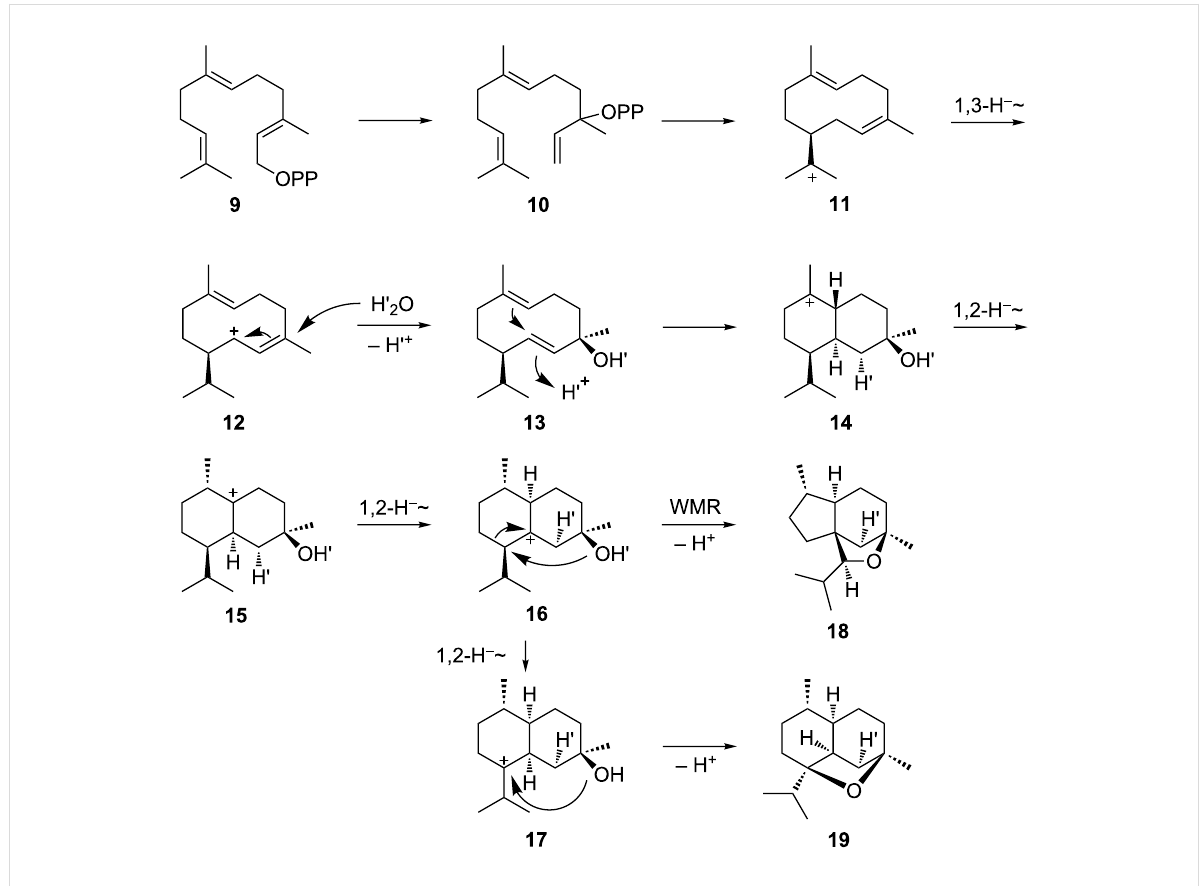
Scheme 2: Mechanism for the cyclisation of FPP to corvol ethers A ( 19 ) and B ( 18 ). WMR: Wagner-Meerwein